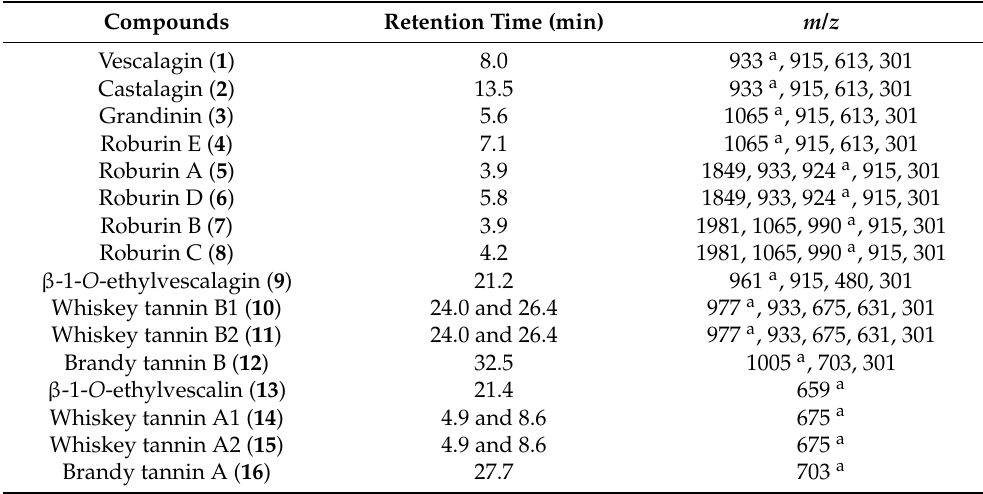
Table 2. HPLC retention times and mass fragmentation patterns of the reference compounds ( 1 – 16